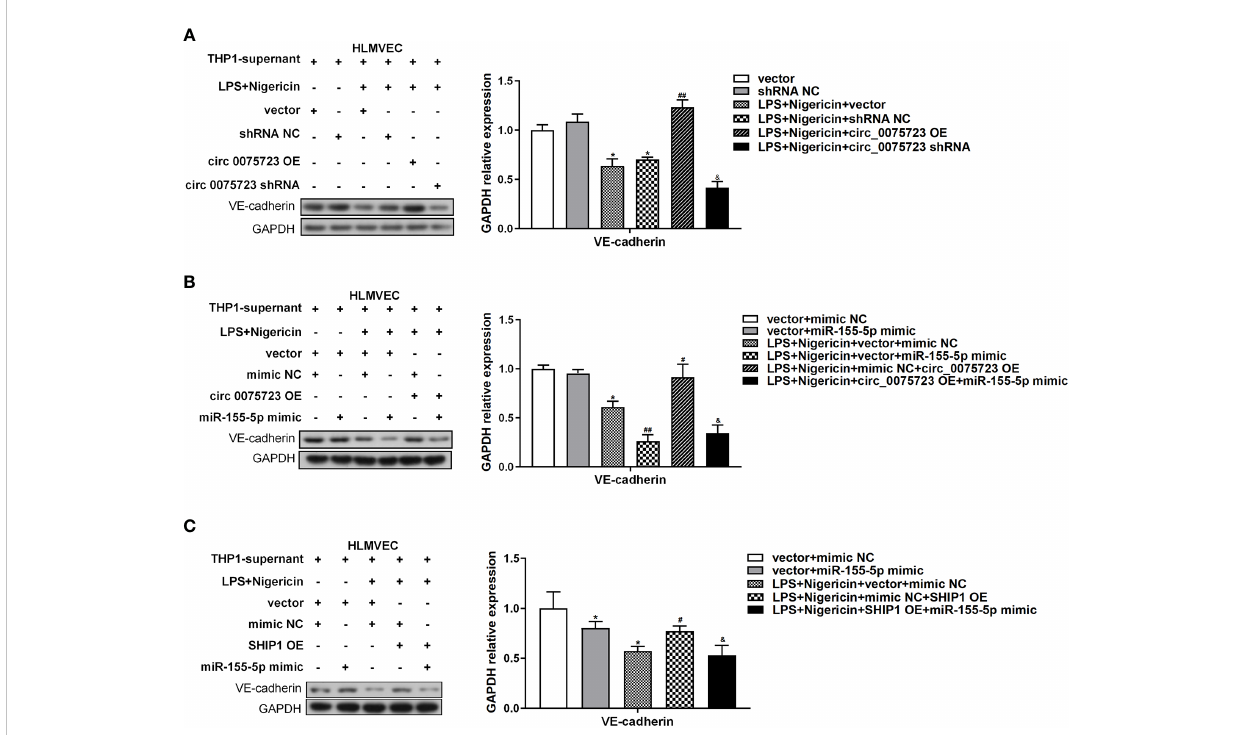
FIGURE 6 Circ_0075723 in macrophages regulate endothelial permeability through the inhibition expression of IL-1 b and IL-18 by circ_0075723/miR-155-5p/ SHIP1 axis. (A) Western blot analysis of VE-cadherin in HLMVEC cultured with the supernatant for 24 h. The supernatant was collected from aforementioned-LPS-primed THP-1 stimulated with nigericin bearing altered expression of circ_0075723. Data are presented as means ± SD; signi fi cant difference was identi fi ed with Student t -tests. *p < 0.05 vs. Vector or shRNA NC; ##p < 0.01 vs. LPS/nigericin + Vector; &p < 0.05 vs. LPS/ nigericin + shRNA NC. (B) Western blot analysis of VE-cadherin in HLMVEC cultured with the supernatant for 24 h. The supernatant was